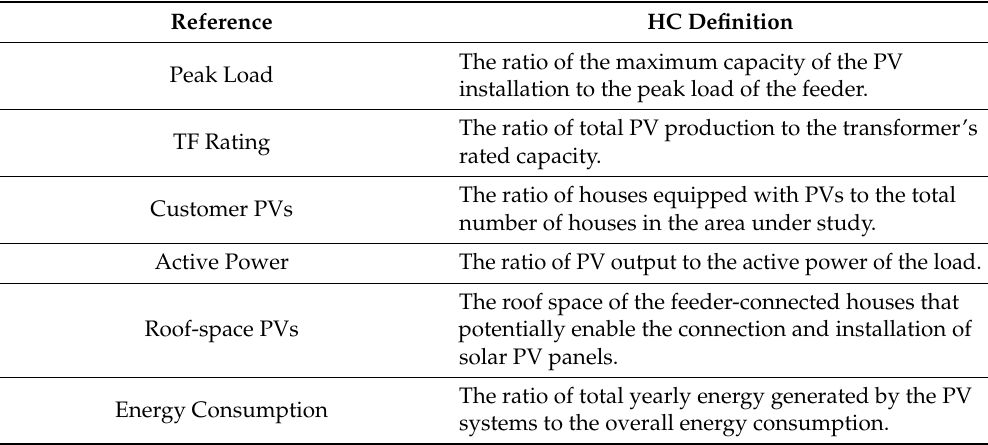
Table 1. HC definitions based on various references adopted for defining